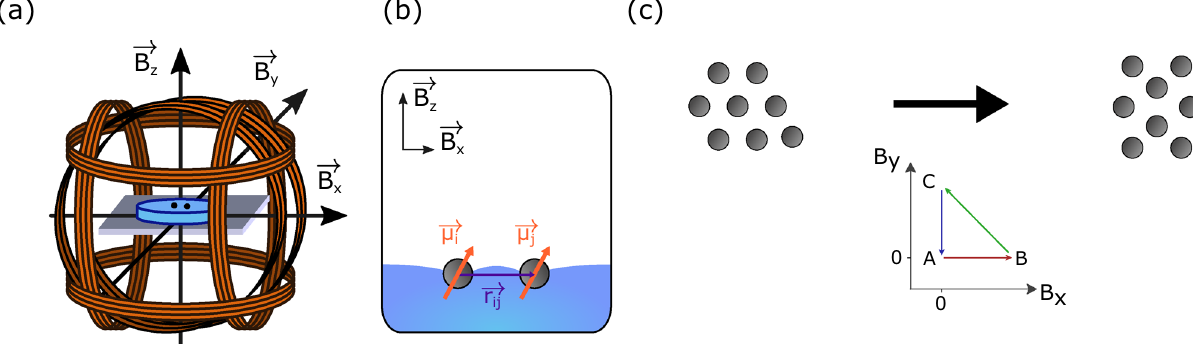
Figure 3. ( a ) First experimental setup composed of three Helmholtz coils producing uniform magnetic fields ( B x , B y , B z ) in the center of the system where the floating crystal self-assemble. ( b ) Influence of a horizontal magnetic field on the magnetic interaction between two particles. ( c ) The cycle ABC in the ( B x , B y ) plane induces structural modifications in the floating crystal and a probability of changing state.